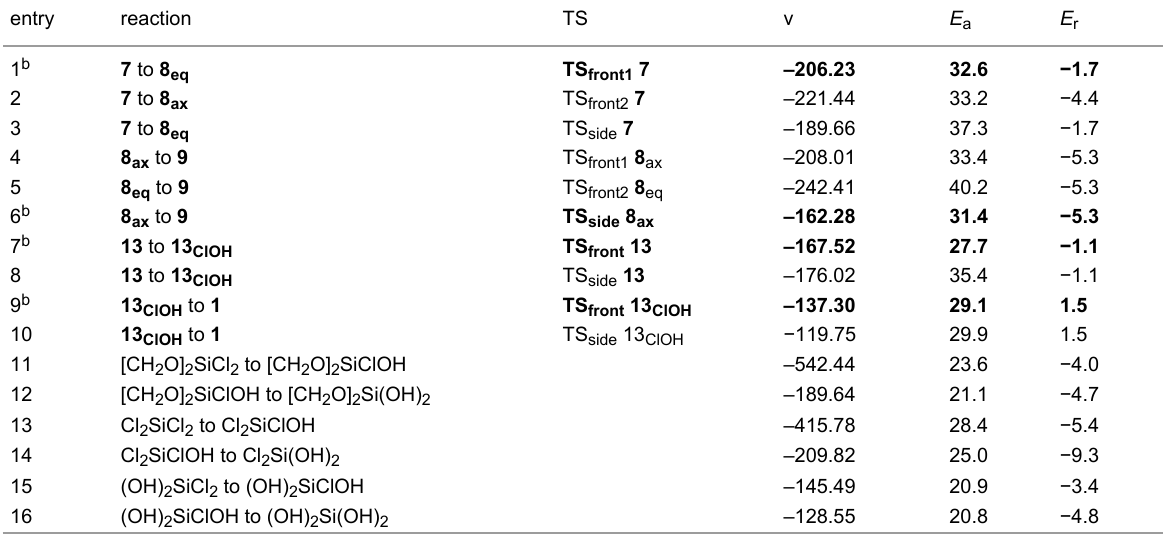
Table 3: Computed a activation energies and reaction energies ( E a and E r [kcal mol − 1 ]) and imaginary frequencies ( ν [cm − 1 ]) of the transition struc- ture (TS) for the hydrolysis of dichlorosilane 7 , 8 , 13 , [CH 2 O] 2 SiCl 2 and SiCl 4 to the corresponding mono- and diols.